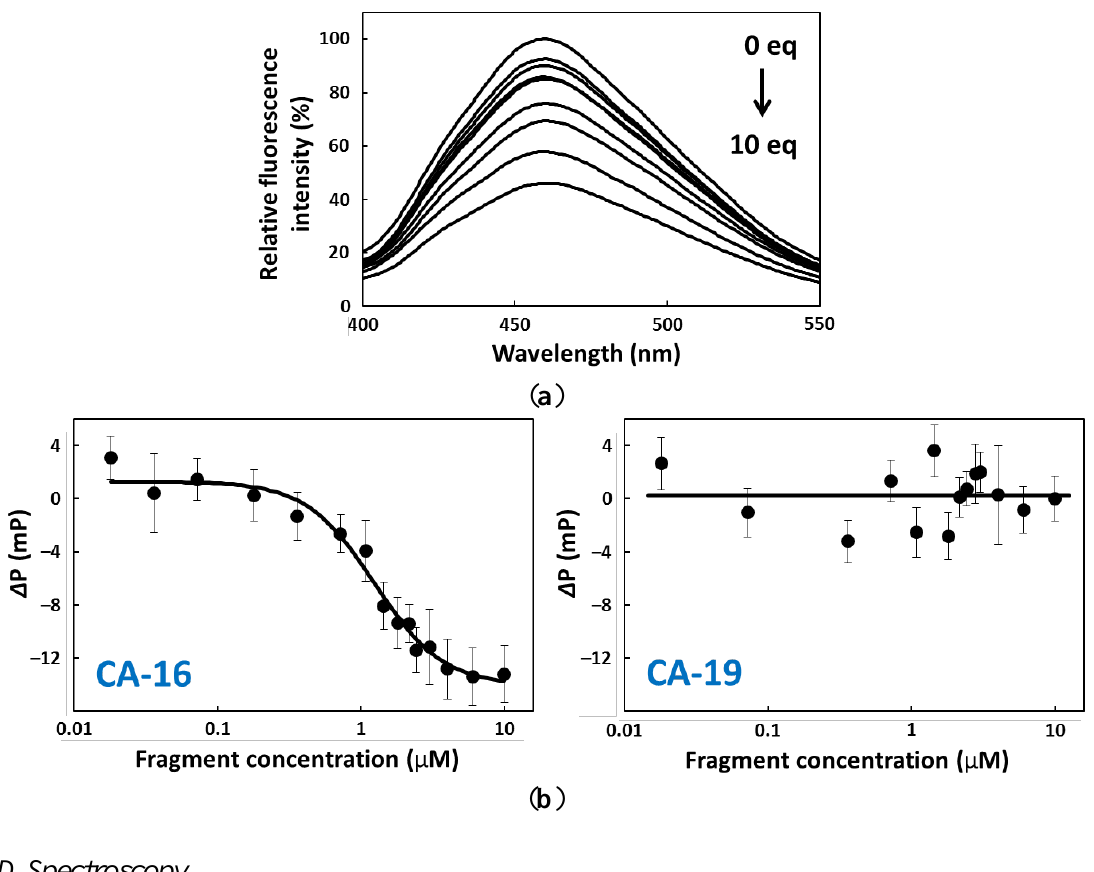
Figure 4. ( a ) Fluorescence spectra for CPT1 with varying CA-16 concentrations and excitation at 372 nm. CPT1 fluorescence without fragment was set at 100%. ( b ) Titration curve for CPT1 polarization versus fragment concentration: CA-16 (left) and CA-19 (right). Polarization was monitored at 456 nm using an excitation wavelength of 372 nm. Δ P = P − P , where P is polarization with fragment, and P is polarization without 0 0